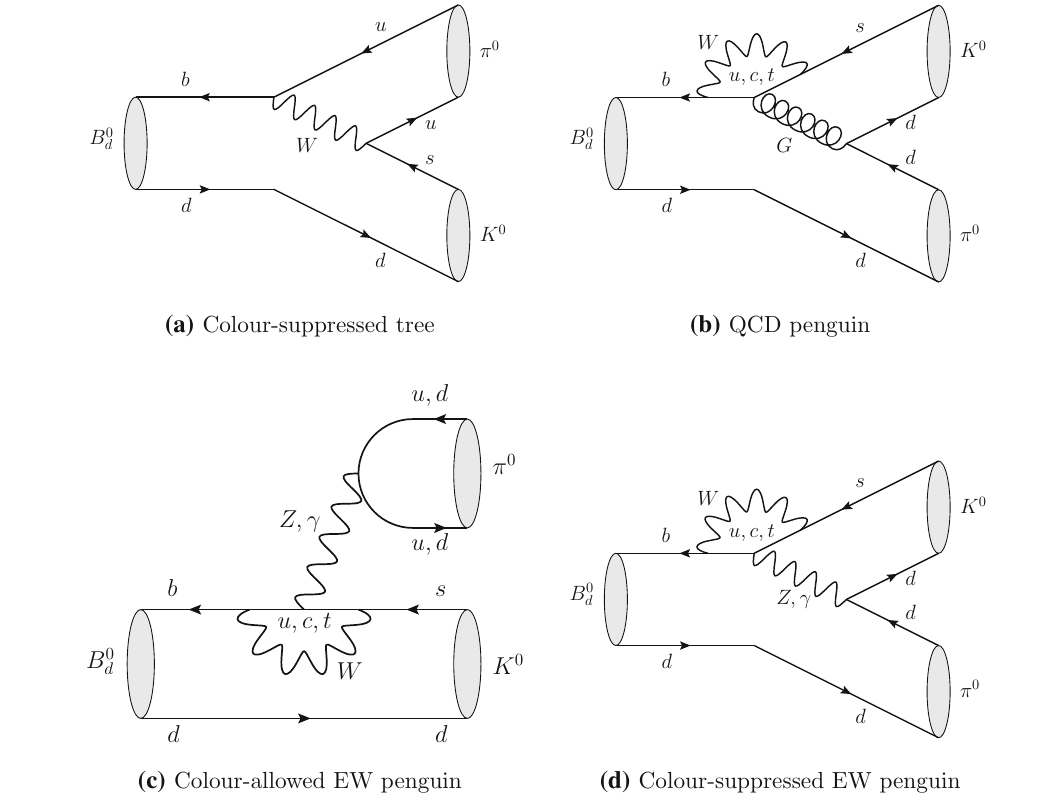
→ π 0 K 0 channel d